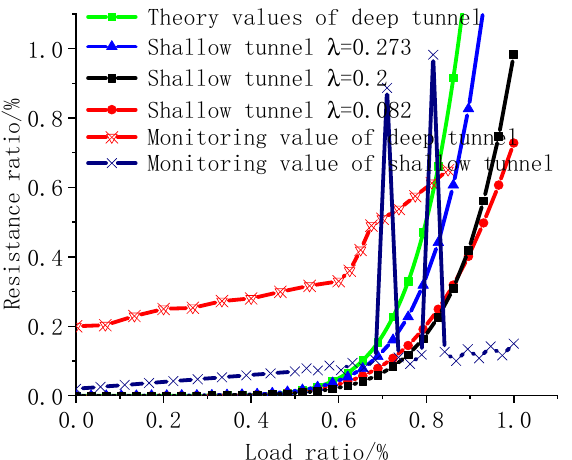
Figure 16. Relationship between theoretically calculated and monitoring values.